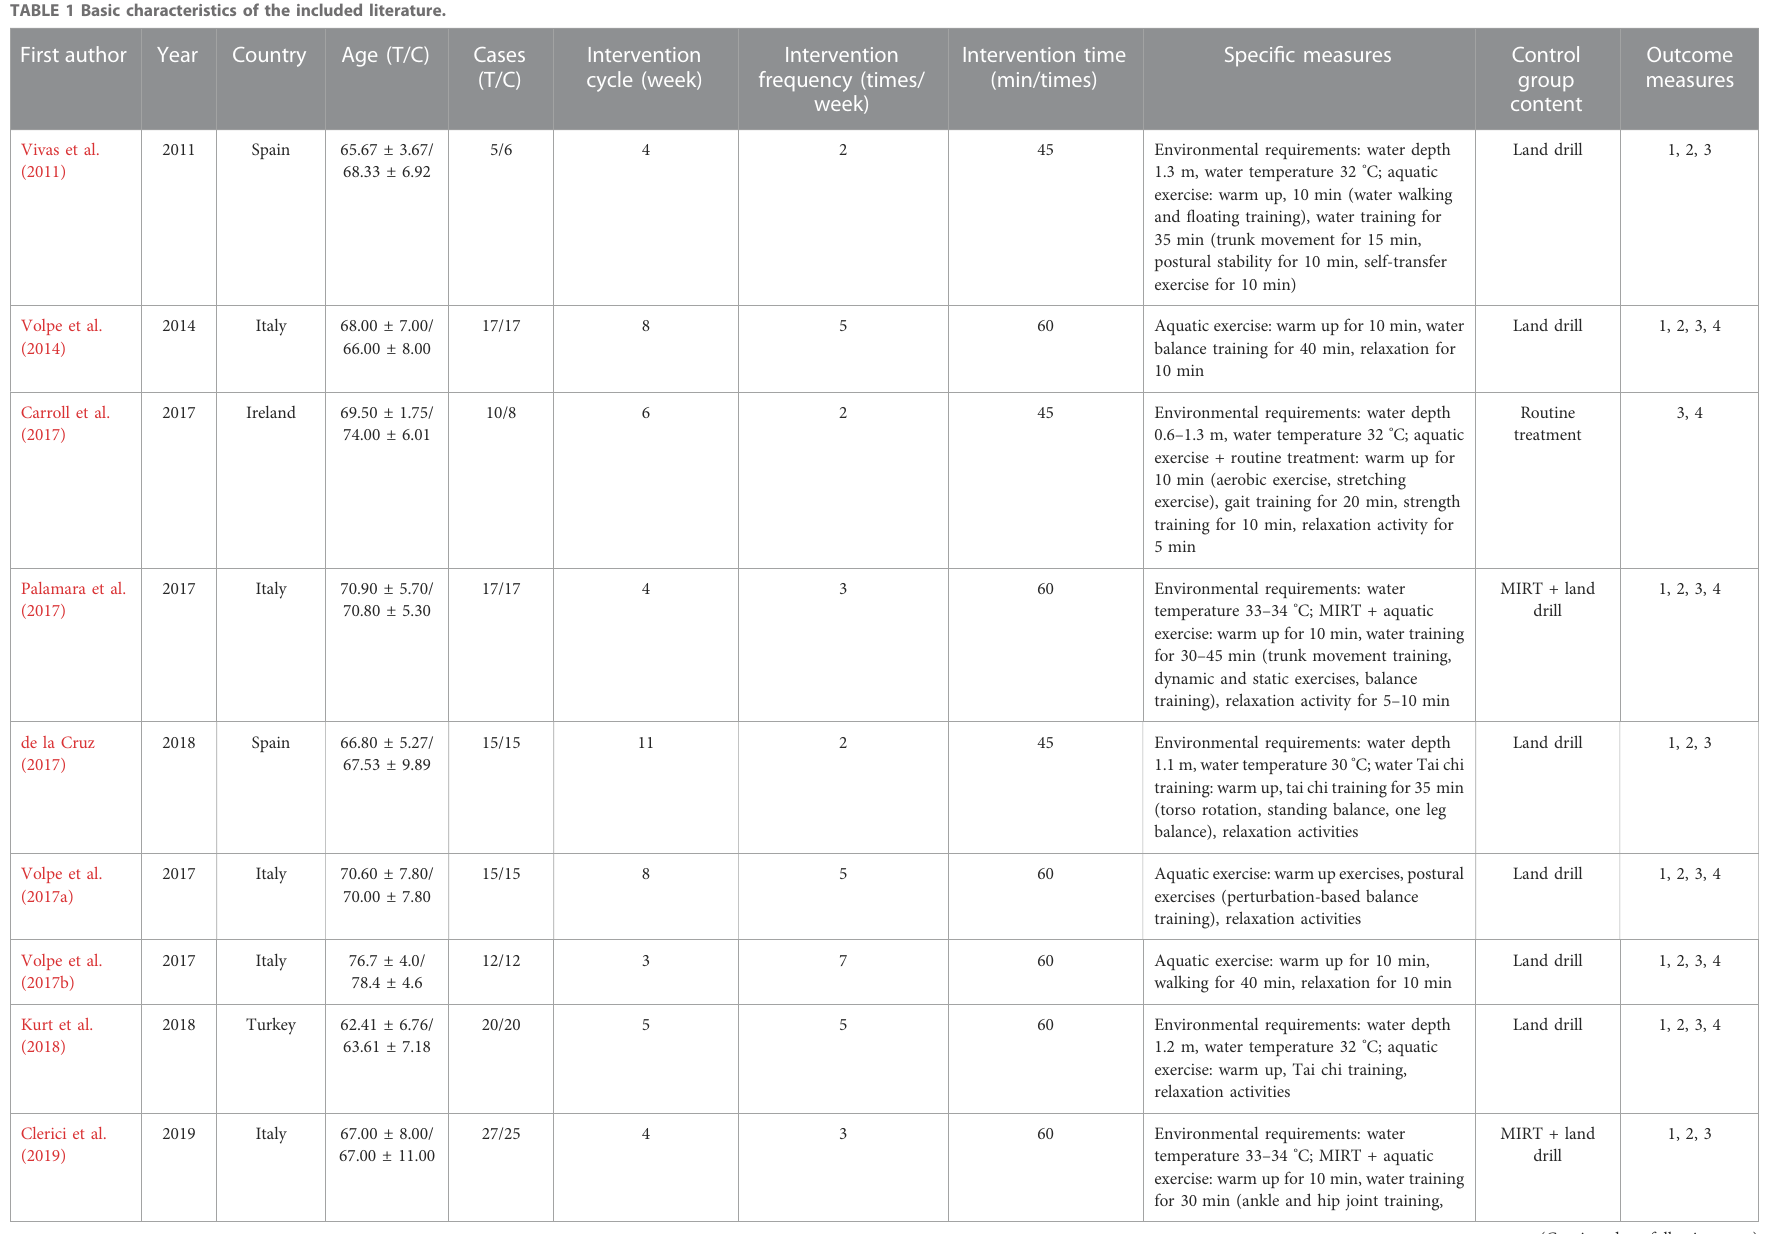
TABLE 1 Basic characteristics of the included